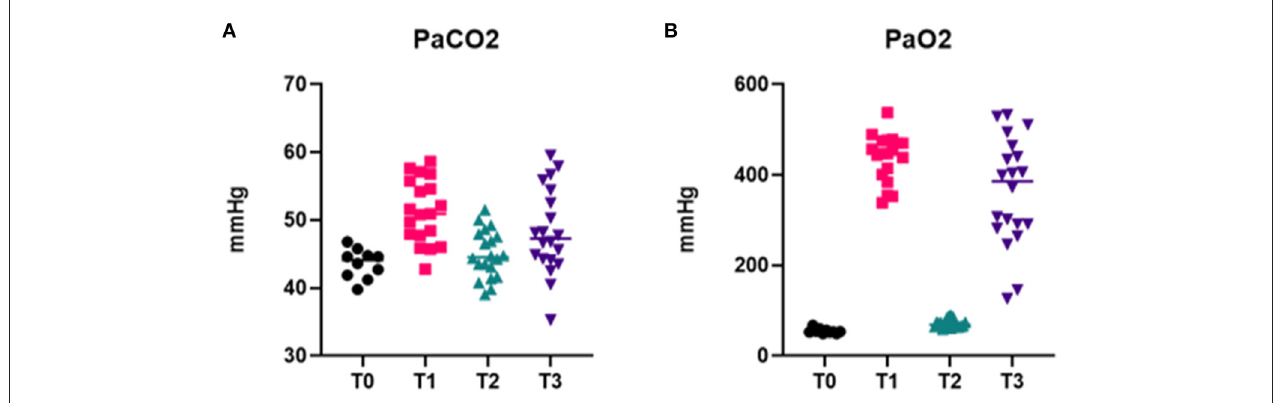
FIGURE 6 | Arterial blood gas data. Graphs showing PaCO 2 (A) and PaO 2 (B) at different time points of the intubation procedure, in presence (T 1 , T 3 ) or absence (T 0 , T 2 ) of O 2